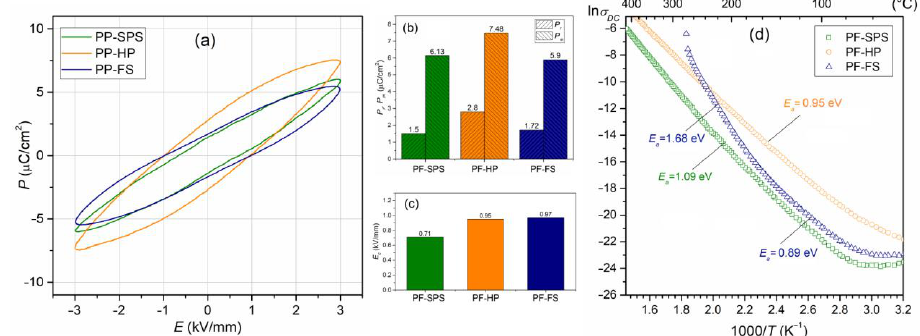
Figure 7. Hysteresis P - E loops (5 Hz, RT ) ( a ), values of the residual and maximum polarizations ( b ), coercive field ( c ), and the ln σ DC (1000/ T ) dependences ( d ) for the PP-F ceramic composites.